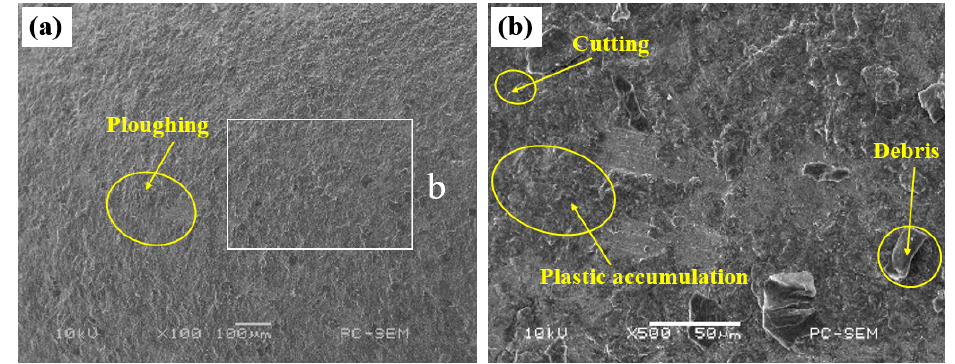
Figure 5. ( a ) SEM morphologies on worn surface II at 100 magnification, ( b ) enlarged view of area b in ( a ) at 500 magnification.